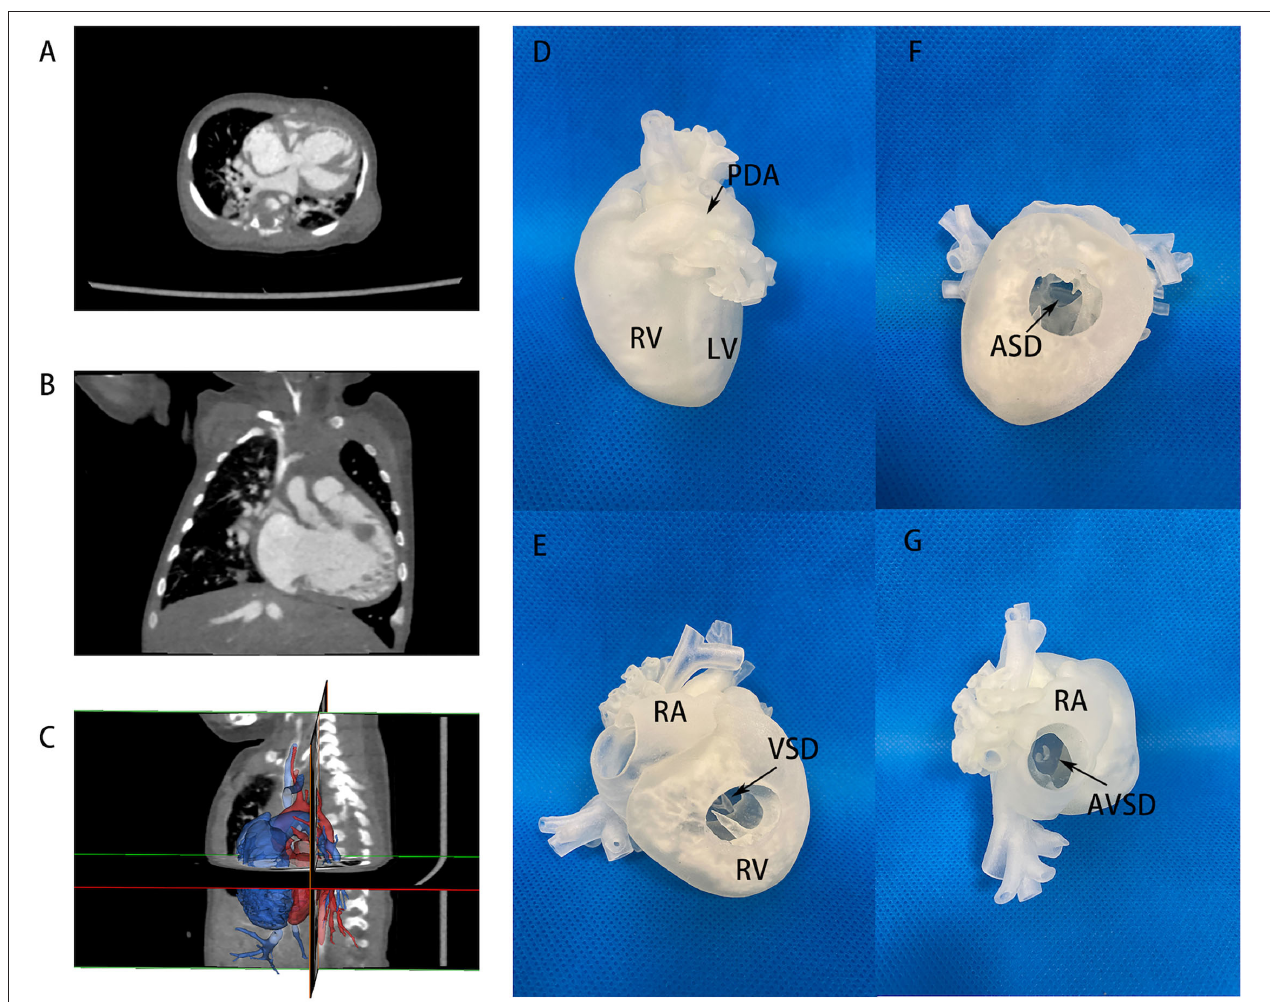
FIGURE 3 | CT images and 3D printing model of case No. 17 in the imbalanced ventricular group. (A,B) CT images of two imbalanced ventricles and AVSD morphology, LV size was very small. (C) Segmentation and reconstruction of the 3D model, the lateral view showed a hidden, small LV posteriorly. (D) 3D printing models in lateral view, showing imbalanced ventricles. (E) 3D printing models in anterior view, VSD channel could be seen in RV incision. (F) ASD location via RV incision. (G) 3D printing models with RA incision. A large common atrioventricular channel was further evaluated. LV, left ventricle; RA, right atrium; RV, right ventricle; Ao, aorta; AVSD, atrioventricular septum defect; PDA, patent ductus